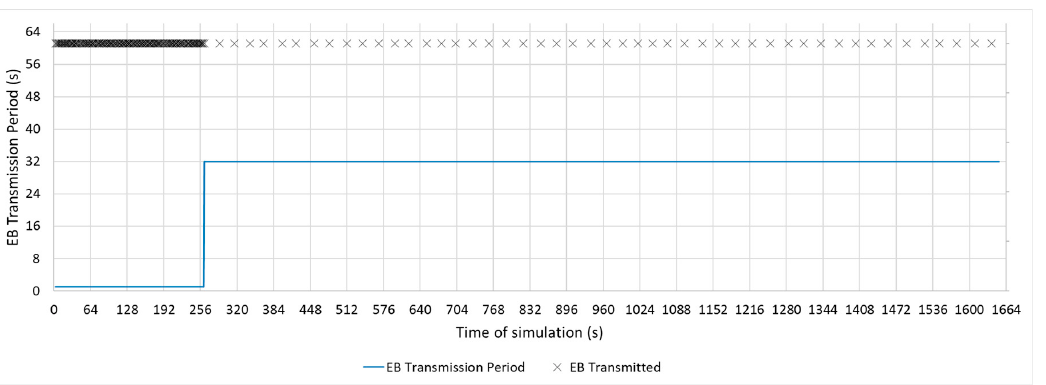
Figure 13. M32s configuration.